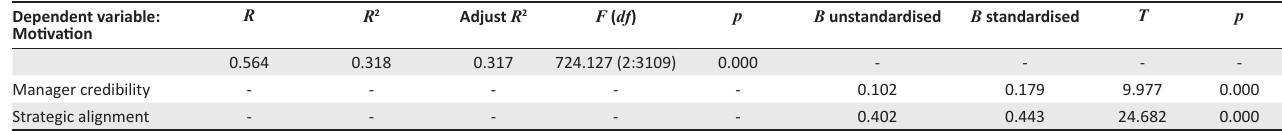
TABLE 2: Standard multiple regression: Manager credibility and strategic alignment as the independent variables and motivation as the dependent variable . Dependent variable: Motivation